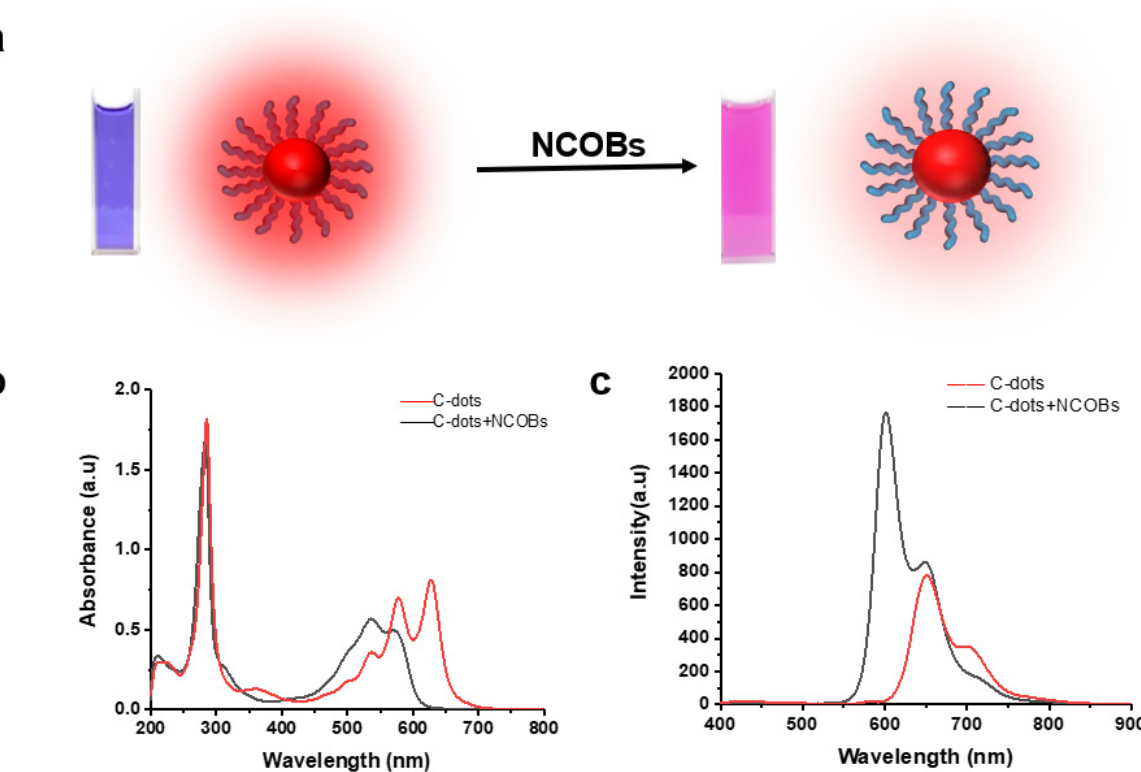
Figure 4. Alternations of C-dots in the presence of NCOBs (pyridine): ( a ) Color change of C-dots solution; ( b ) UV–vis absorption change of C-dots; and ( c ) PL emission change of C-dots.